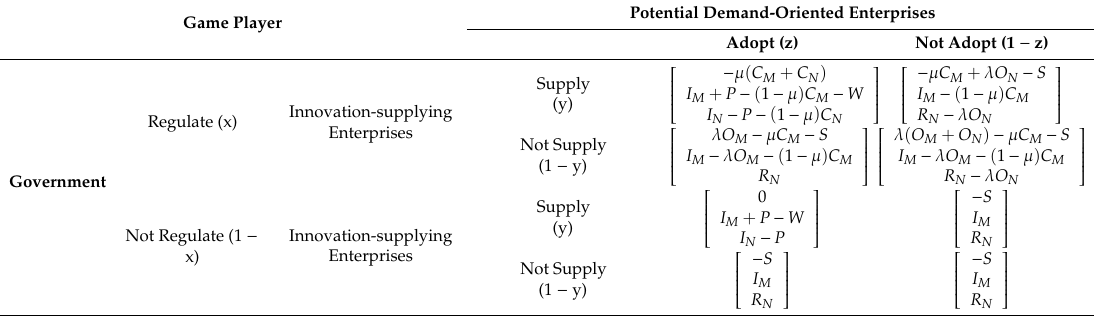
Table 2. The revenue of the game matrix among the government, innovation-supplying enterprises, and potential demand-oriented